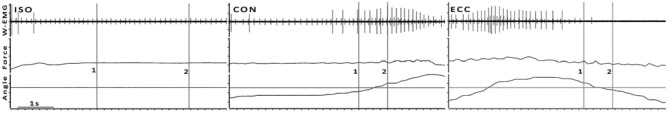
Examples of ISO, CON and ECC trials from one subject at 10% MVC. Cursors 1 and 2 mark the beginning and end of analysis, respectively. In dynamic contractions Cursor 1 is 200 ms prior and Cursor 2 200 ms after the angle crosses the angle of the ISO trial, as indicated by the horizontal cursor. This figure is a typical wire electrode recording (W-EMG), where the recruitment of an additional motor unit in CON and a derecruitment of active units in ECC can be observed (see Section Discussion for details).